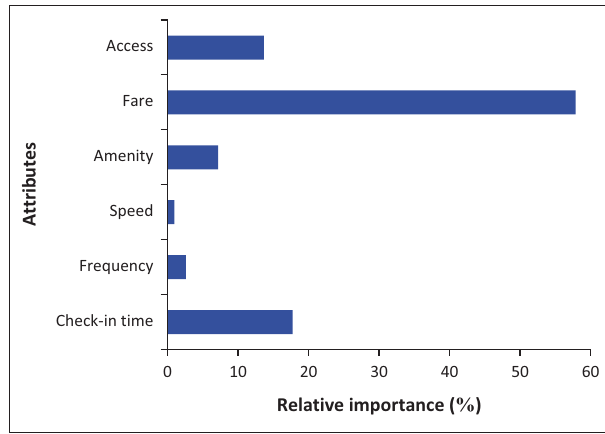
FIGURE 2: Average importance of attributes.